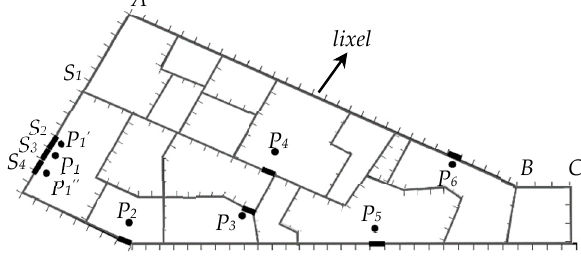
Figure 4. An example of network tessellation .